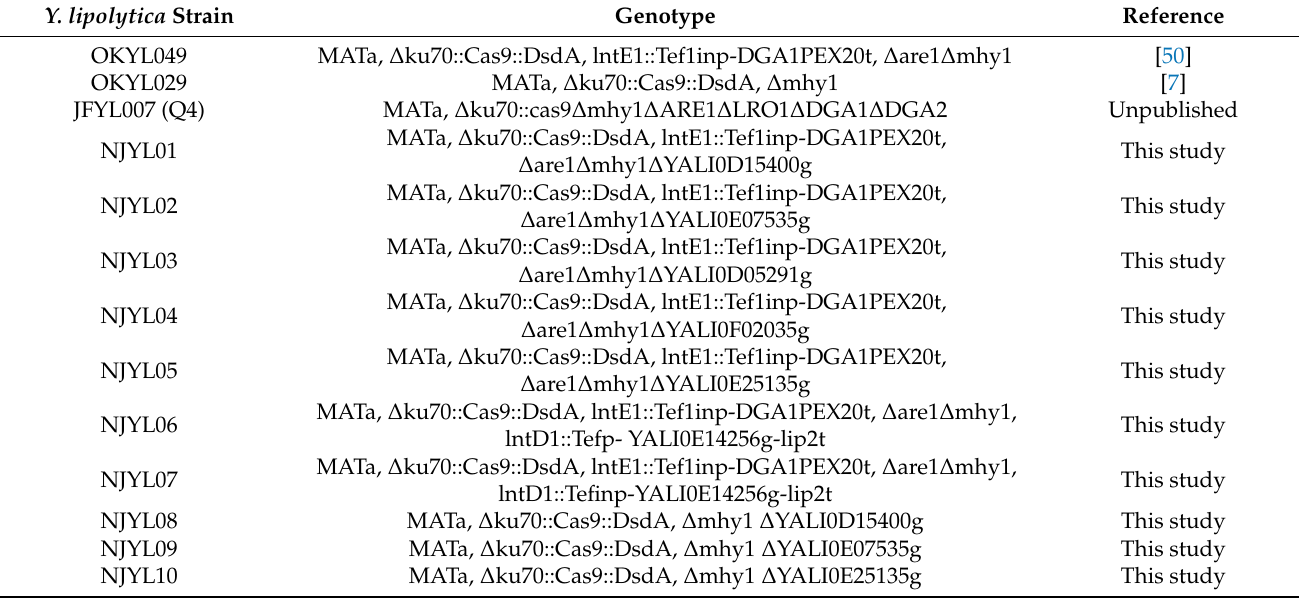
Table 4. Y. lipolytica strains used in the current